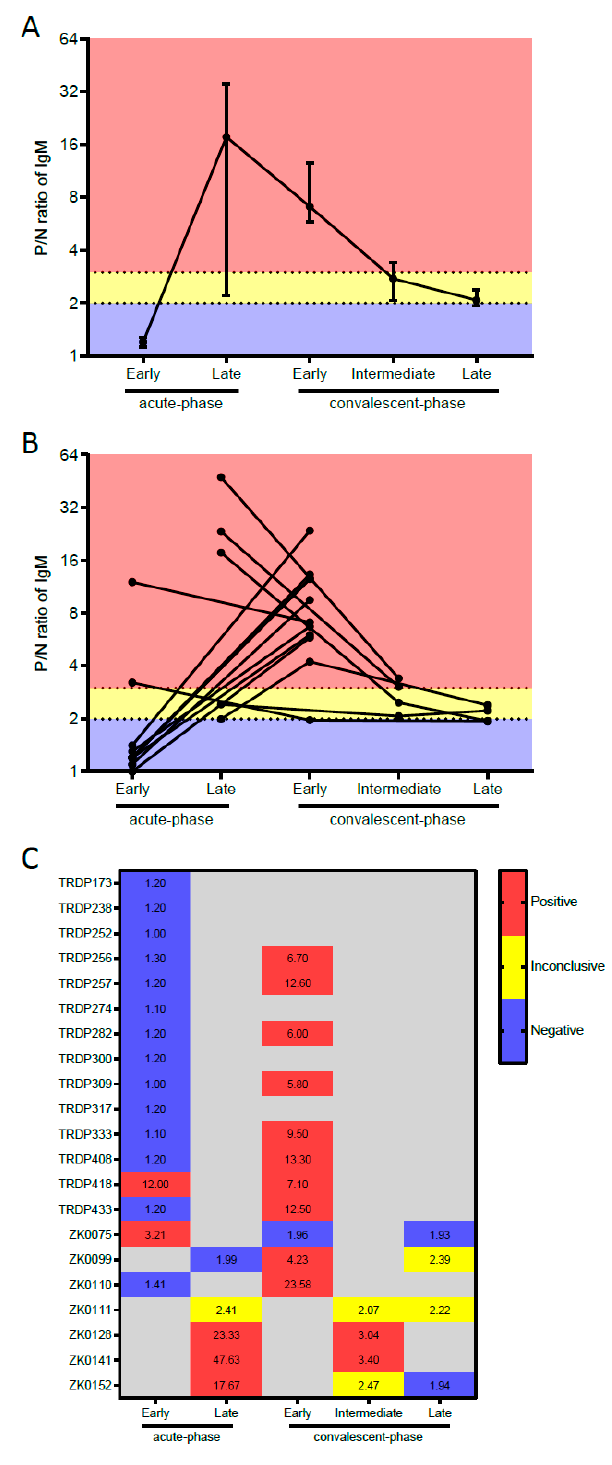
Figure 1. Kinetics of IgM detection against ZIKV over time. Positive / negative (P / N) ratio values obtained by ZIKAV MAC-ELISA-CDC from serum samples from ZIKAV-infected patients originally diagnosed by qPCR Trioplex-CDC at di ff erent time points (Acute phase, Early convalescent phase, Intermediate convalescent phase, and Late convalescent phase). ( A ) Line plot with superimposed symbols at median with interquartile range, ( B ) Dot plot with before / after lines per patient and ( C ) Heatmap indicating the P / N ratio values of IgM for each ZIKV-infected patient serum samples. Legend: blue (negative—P / N < 2), yellow (inconclusive—2 < P / N < 3), red (positive—P / N ≥ 3) and grey (missing sample due to di ff erent cohort